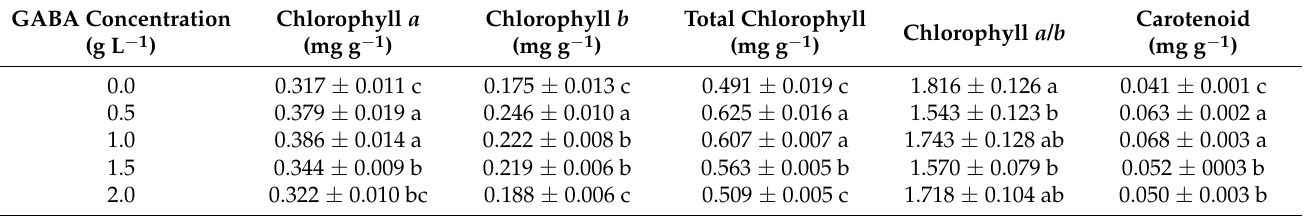
Figure 2. Total N content in loquat seedlings under the influence of gamma amino butyric acid. ( A ): Root N content; ( B ): shoot N content. Values are means (±SD) of three replicates. Different lowercase letters indicate significant differences among the treatments (Duncan’s Multiple Range Table 1. Photosynthetic pigment content in loquat seedling leaves under the influence of gamma Test, P < 0.05). GABA = gamma amino butyric acid. amino butyric acid.